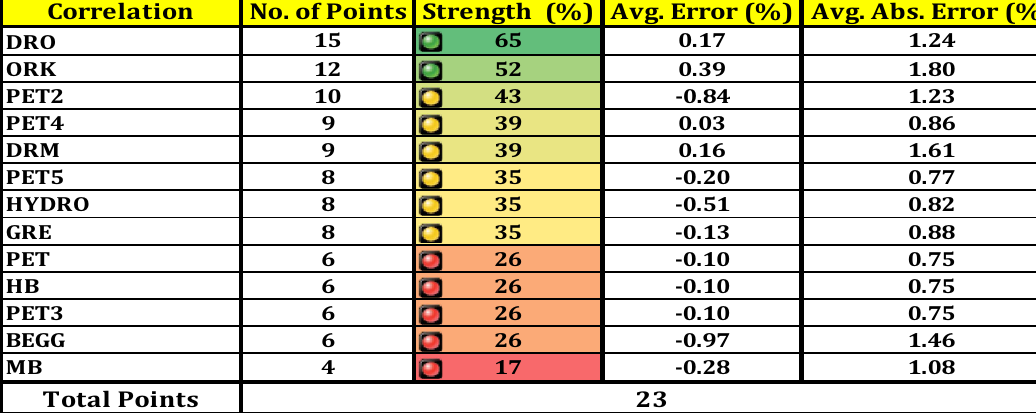
Table 5 Sample of complete results for one sub-cluster [after Abd El-Moniem and El-Banbi (2015)]